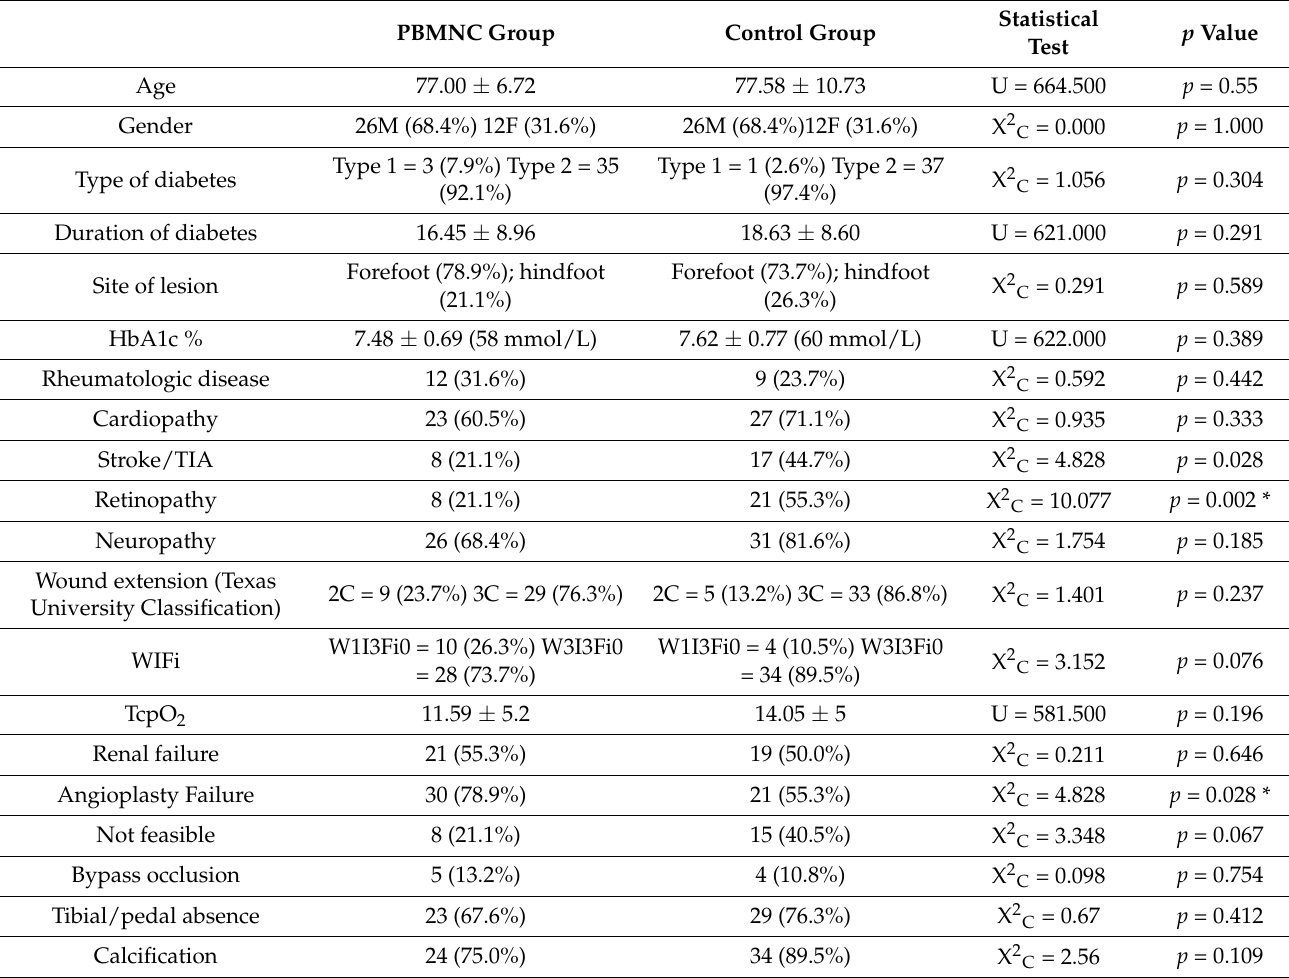
Table 1. Patient features and baseline